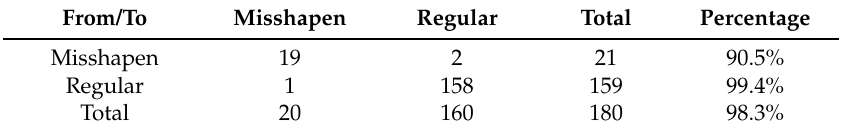
Table 4. Confusion matrix of discriminant model for predicting the shape of training set mangoes. From/To